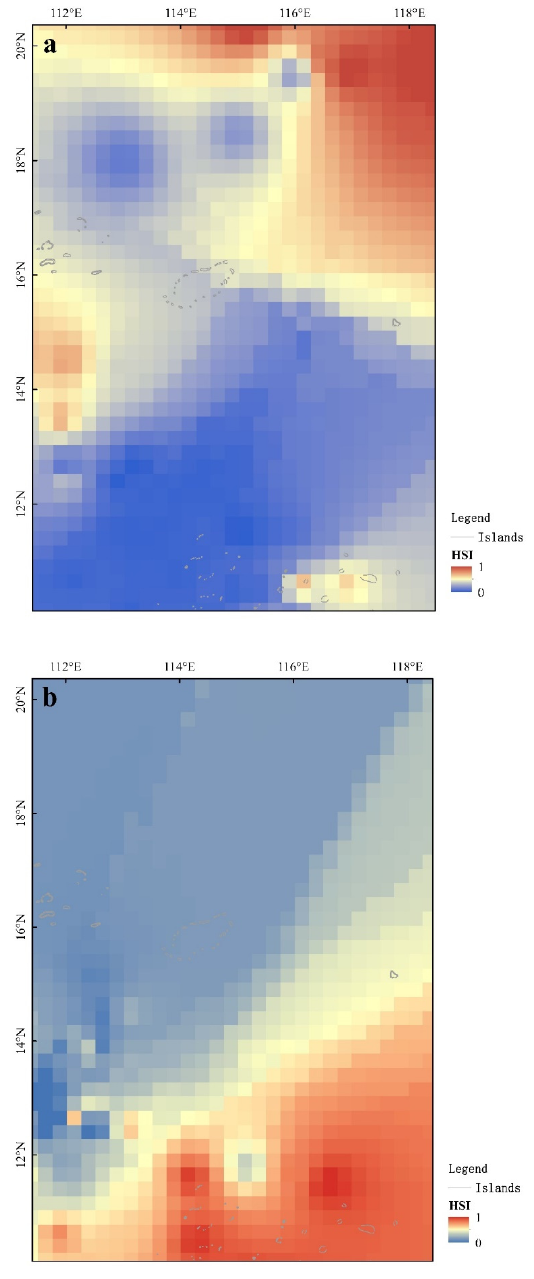
Figure 5. Distribution of A. thazard HSI in spring and summer, South China Sea: ( a ) Distribution of A. thazard HSI in spring; ( b ) Distribution of A. thazard HSI in summer.